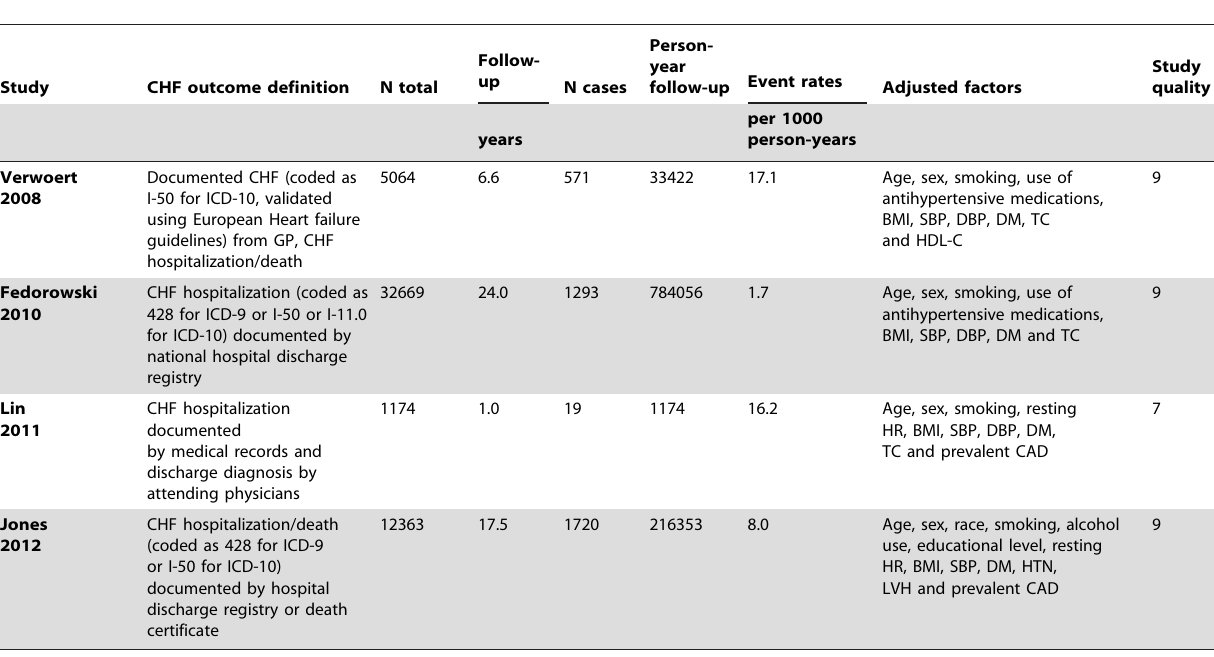
Table 2. Congestive heart failure outcome definitions and follow up data in the prospective cohort studies included in the meta- analysis.